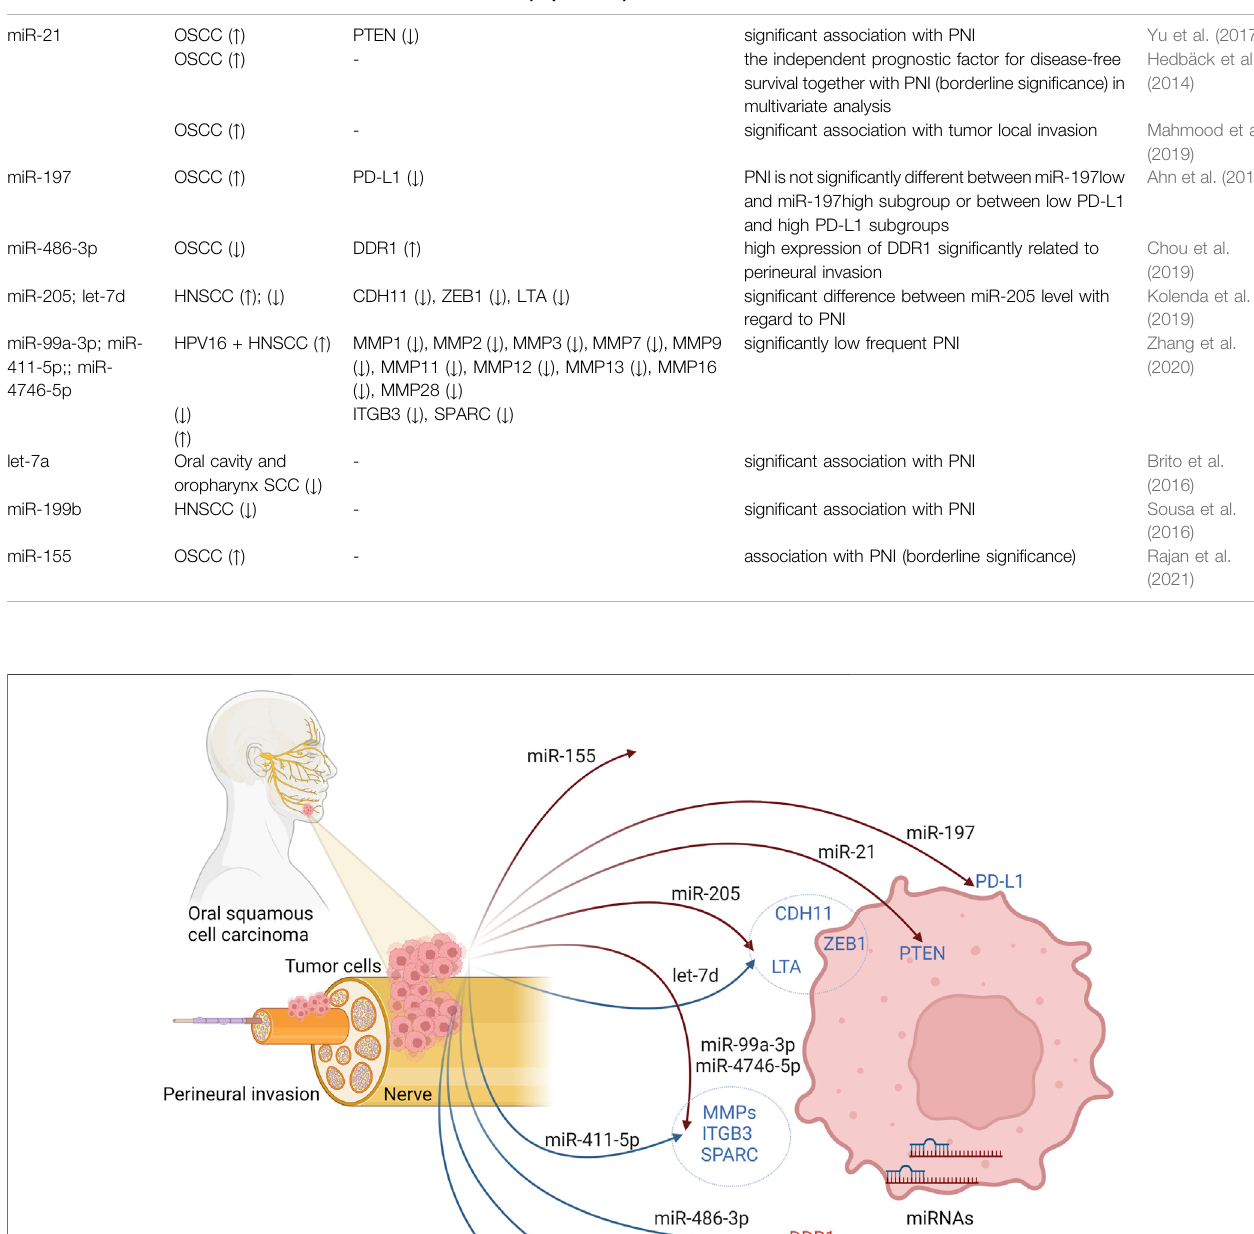
TABLE 3 | Short non-coding RNAs associated with PNI. miRNA